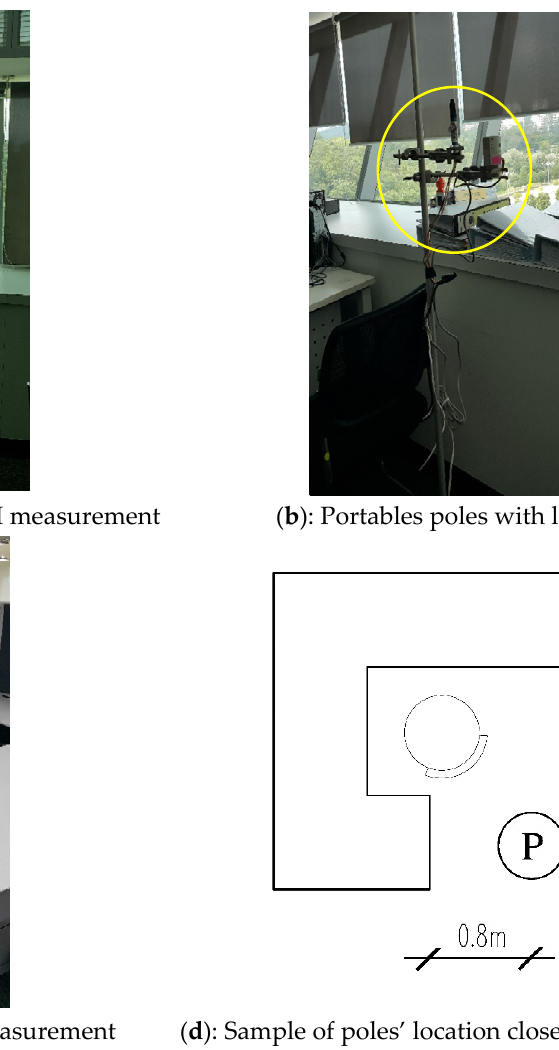
Figure 2. Demonstration of equipment installed to monitor indoor environment quality (IEQ). Table 3. Specifications of equipment for physical measurement of indoor environment parameters.